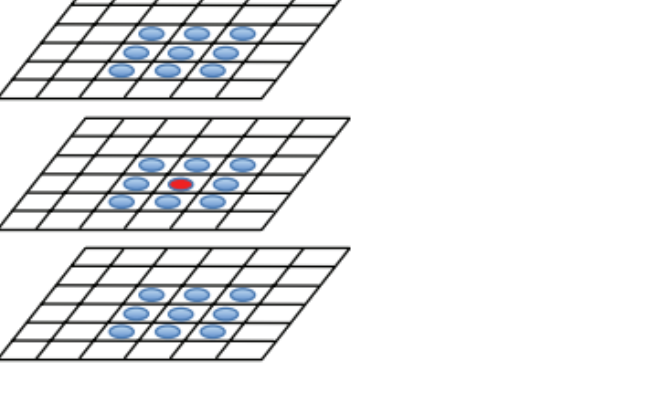
Figure 6. Detection of feature points. The sample point is marked by a red circle, and its neighbors from the same and different scales are marked with a blue circles. Adapted from